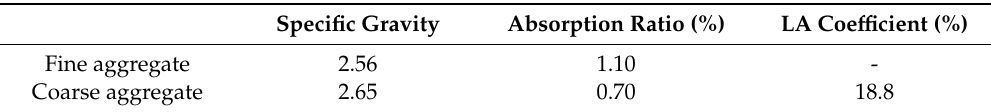
Table 2. Natural aggregate material properties.